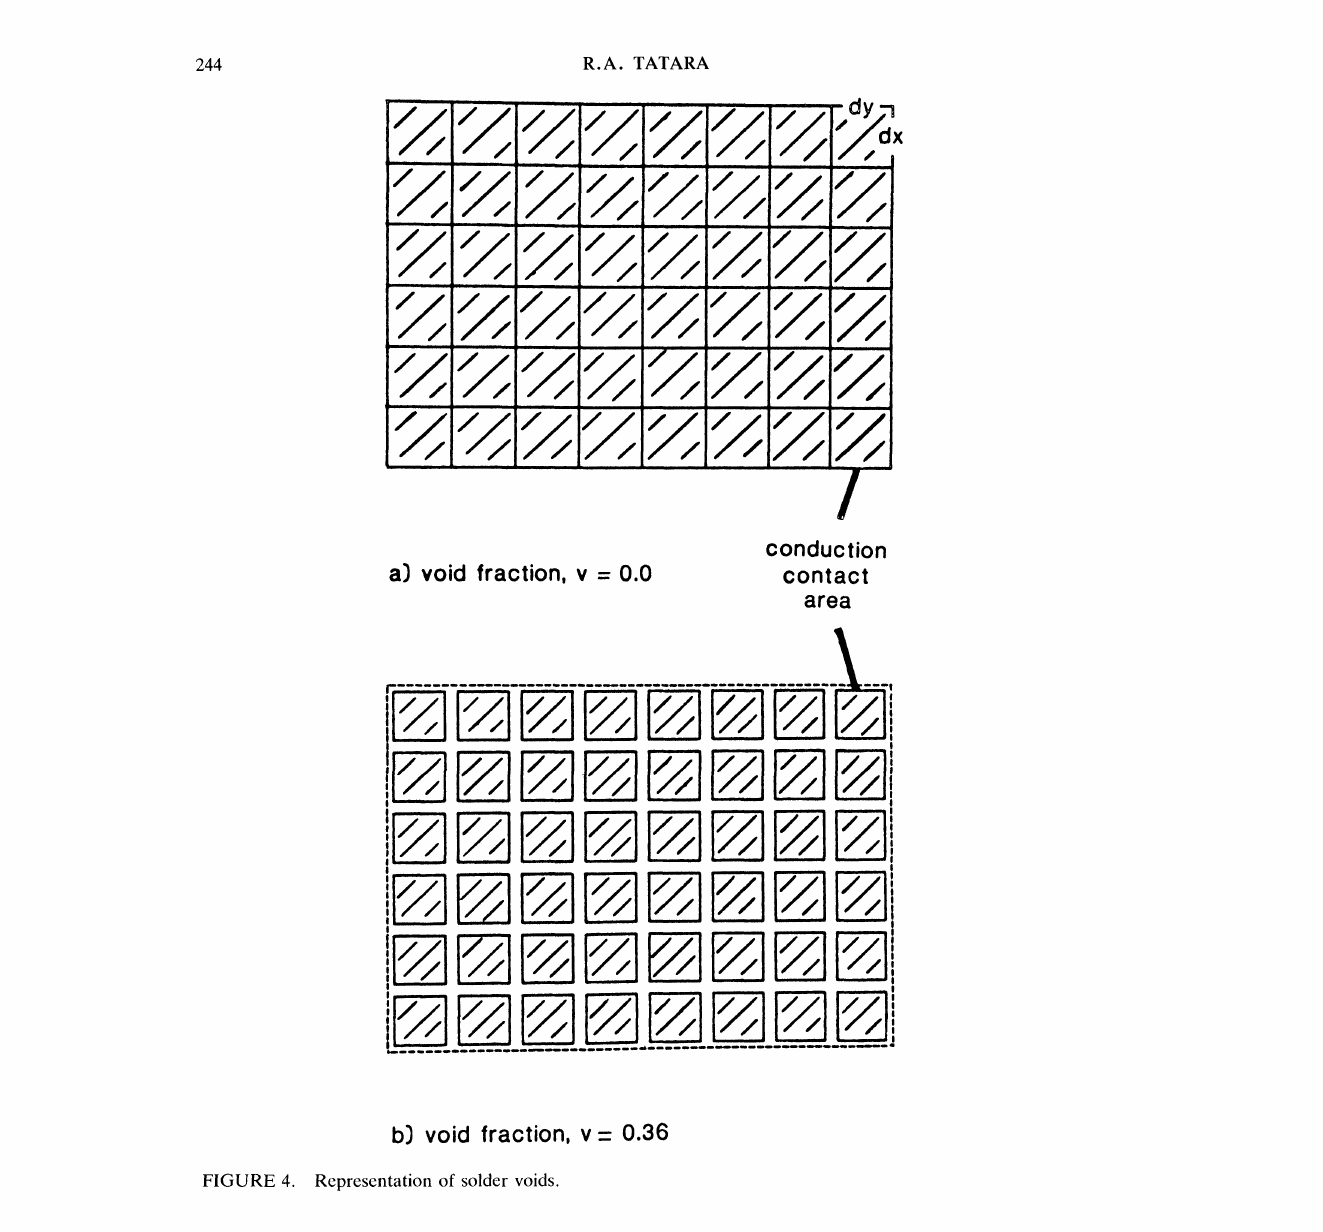
FIGURE 4. Representation of solder